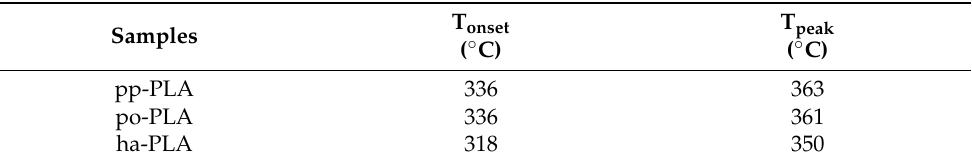
Table 4. Degradation temperatures of onset and maximum peak of samples in an inert atmosphere. Errors in T ± 1 ◦ C.